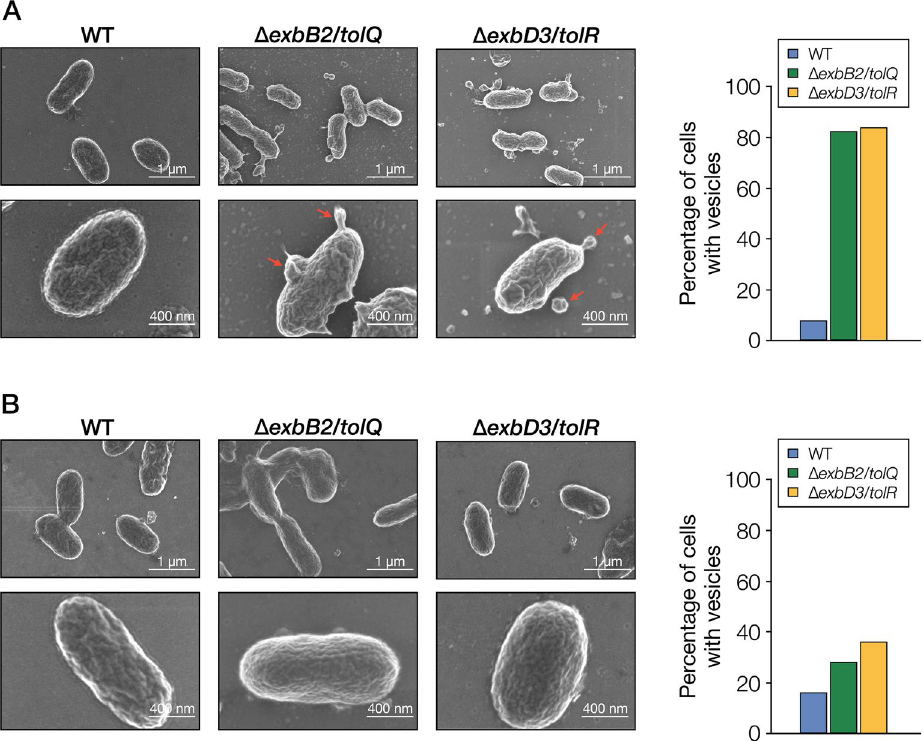
Figure 6. SEM analysis of SYK-6, ∆ exbB2 / tolQ , and ∆ exbD3 / tolR . ( A ) FE-SEM images of SYK-6, ∆ exbB2 / tolQ , and ∆ exbD3 / tolR cells grown in LB. Red arrows indicate blebbing vesicles. ( B ) FE-SEM images of SYK-6, ∆ exbB2 / tolQ , and ∆ exbD3 / tolR cells grown in LB with 5 mM FA. The right figure shows the percentage of cells with vesicles. Outer membrane vesiculation was quantified by imaging 50 bacterial cells and expressed as the percentage of cells with OMV. This figure was generated using Canvas X Draw version 7.0.2. (https:// www. canva sgfx. com/ produ cts/ canvas- x-